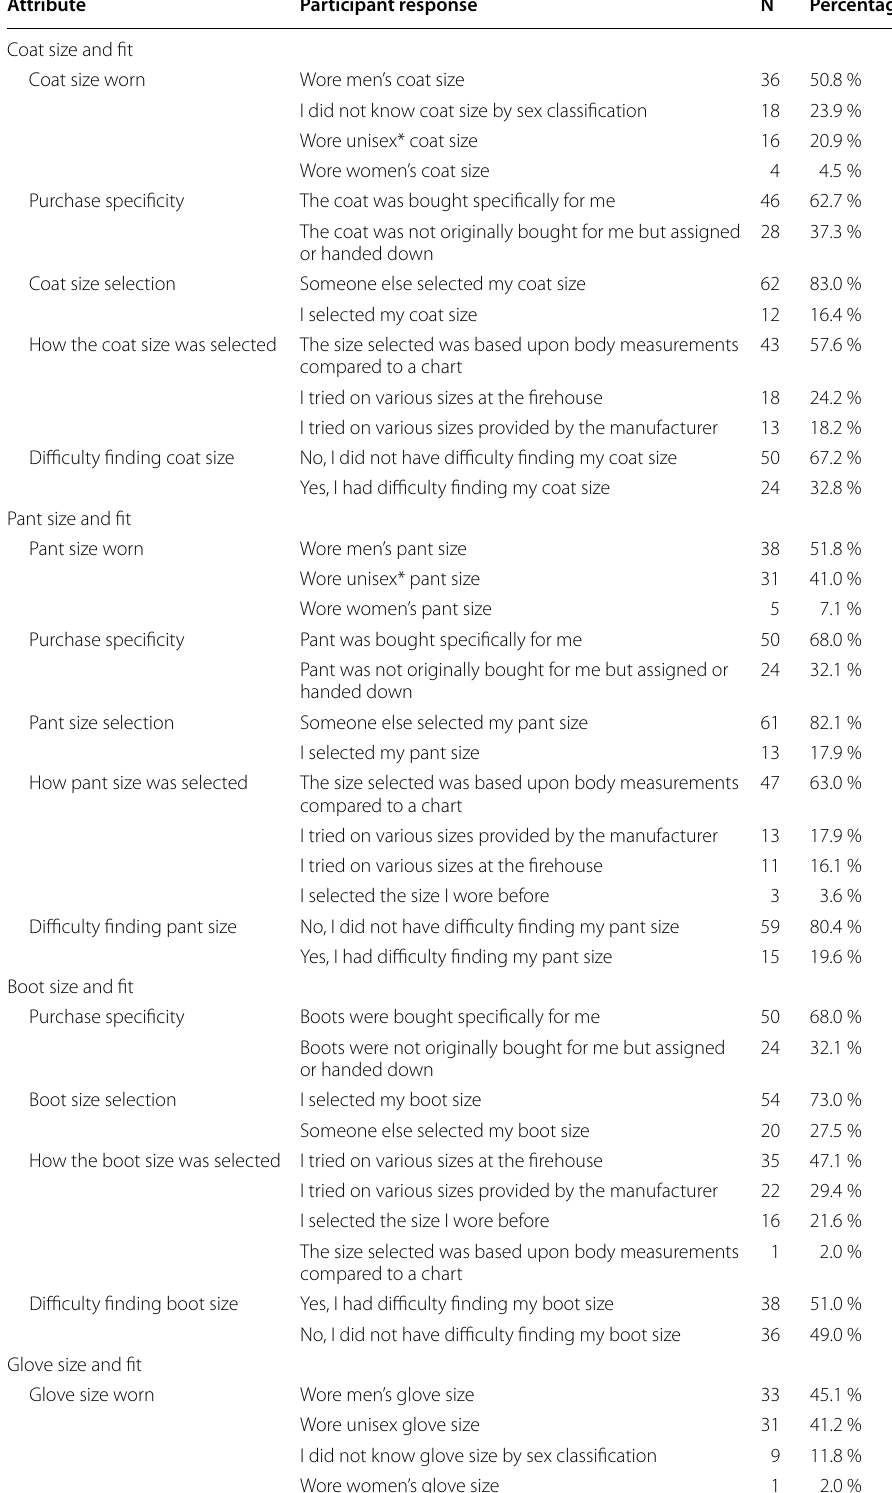
Table 6 Summary of survey